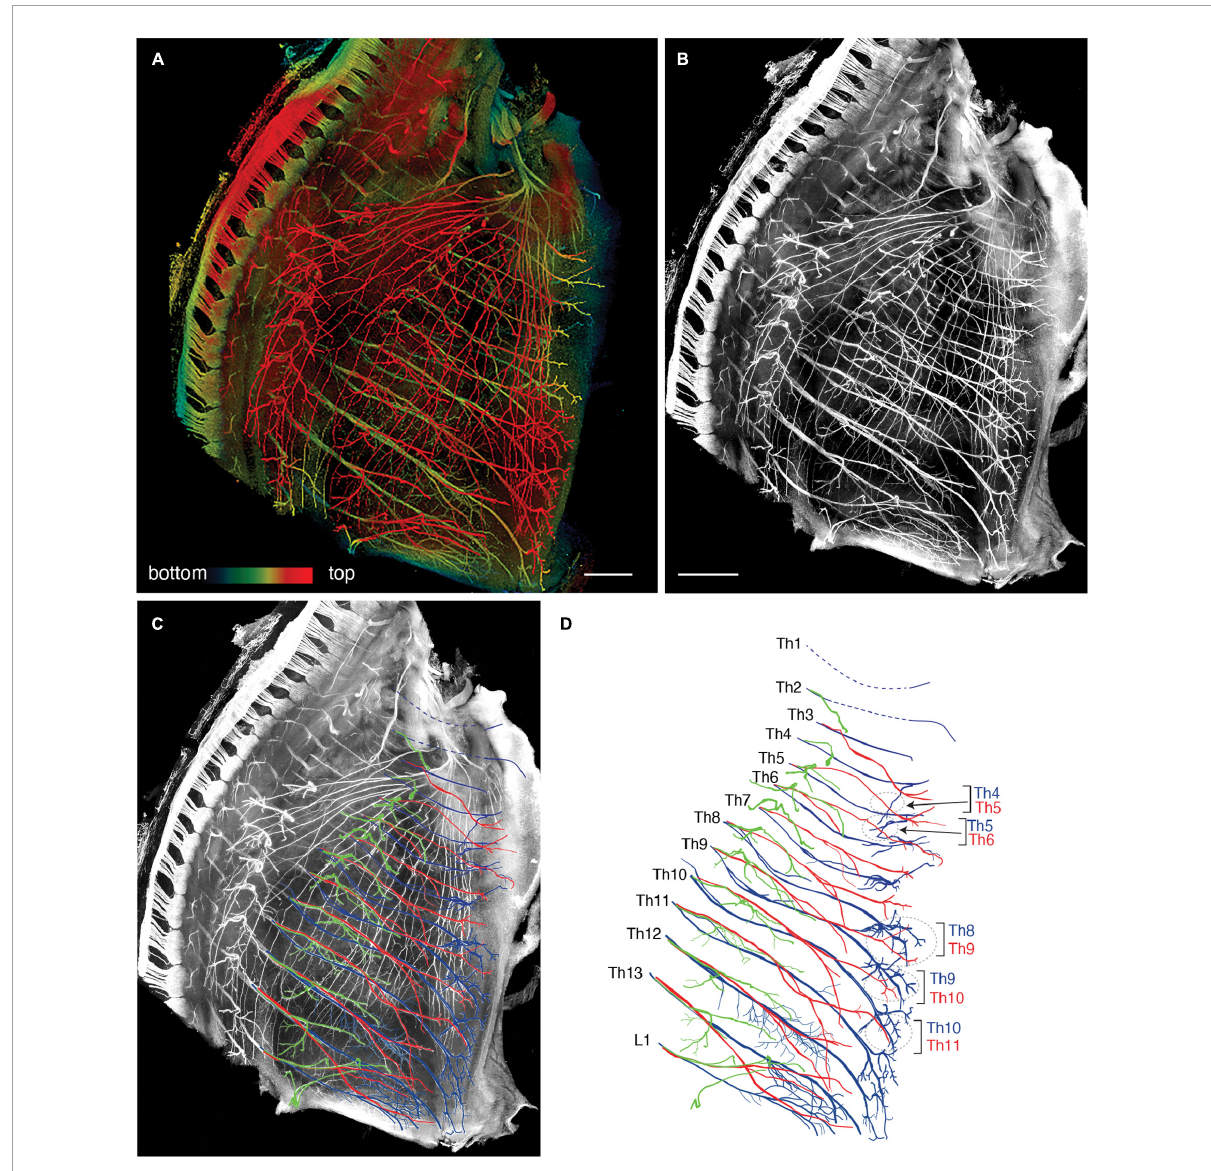
FIGURE2 Branching pattern of the intercostal nerve in a transparent thoracic wall from a mouse embryo on E13. All micrographs are the unilateral side of the thoracic wall, and are in surface view. The dorsal side is toward the left of the micrographs. The anterior side is toward the top of the micrographs. (A) MIP image. Nerve branches are color-coded; those close to the outer surface are colored red, and those close to the parietal surface are blue. (B) A micrograph of a black and white MIP image without depth information. The vertically running branches are for the dermal panniculus muscle from the brachial plexus (Petruska et al., 2014). (C) Traced intercostal nerves; the deep branches (blue), superficial branches (red), and lateral cutaneous branches (green). When the surface skin was peeled off, the terminal branches of the lateral cutaneous branches were also removed. No tracing of the branches for the dermal muscle is included. (D) Illustration of the traced branches. The deep branches are in blue; the superficial branches are in red; and the lateral cutaneous branches are in green. The hatched circles indicate overlapping innervations by the nearby superficial and deep